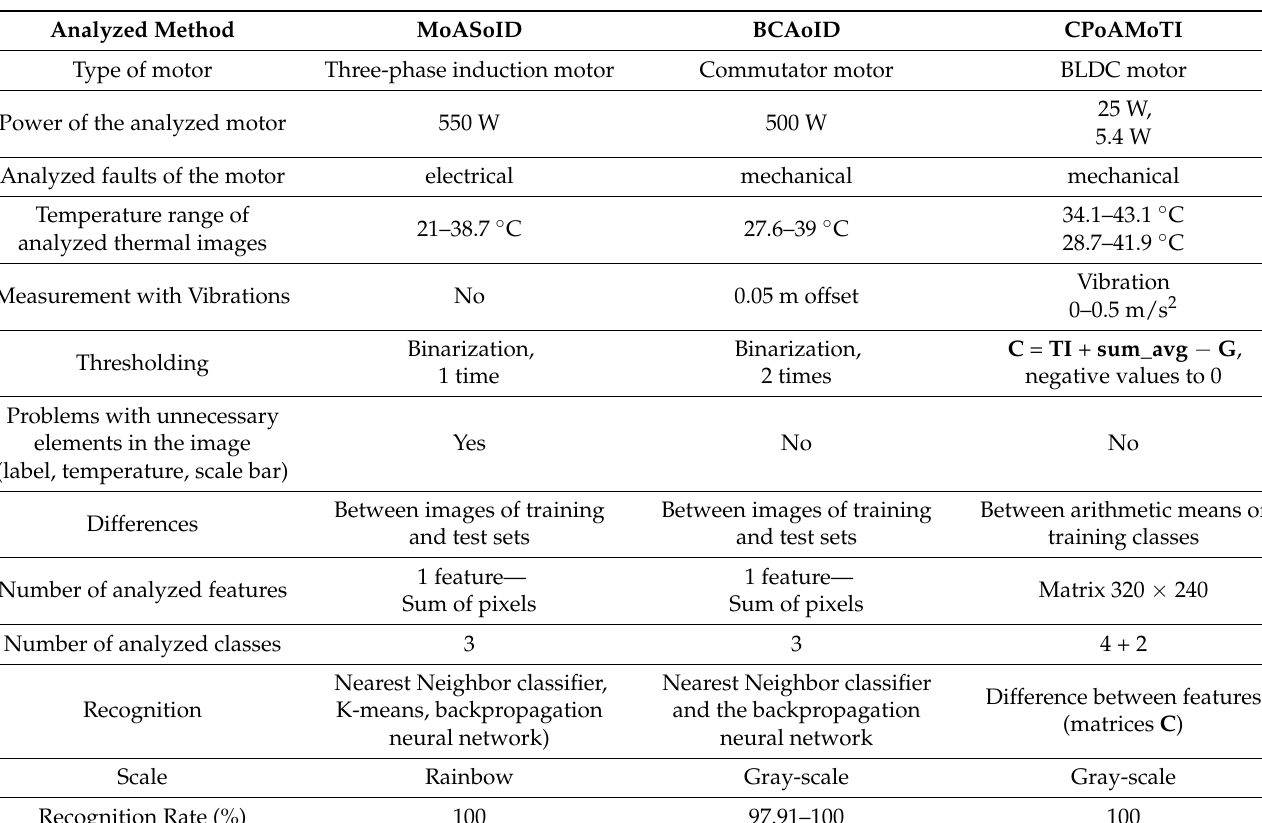
Table 5. Comparison of analysis and methods: MoASoID, BCAoID and